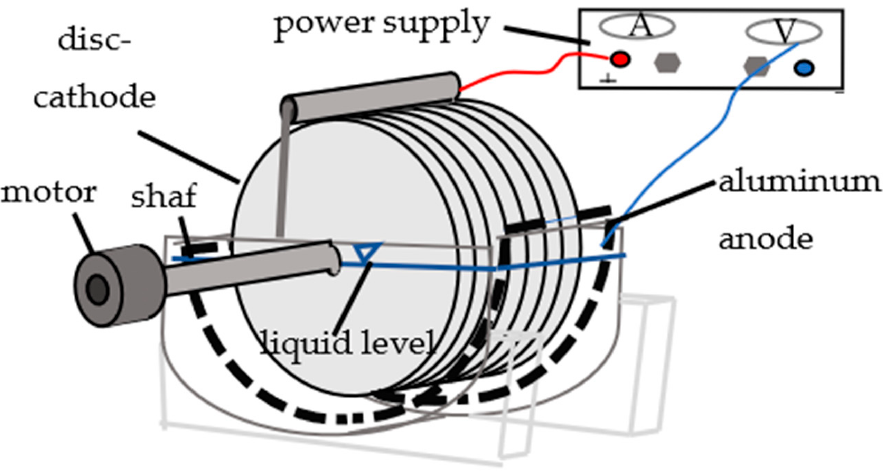
Figure 1. Scheme of the unit experimental model.